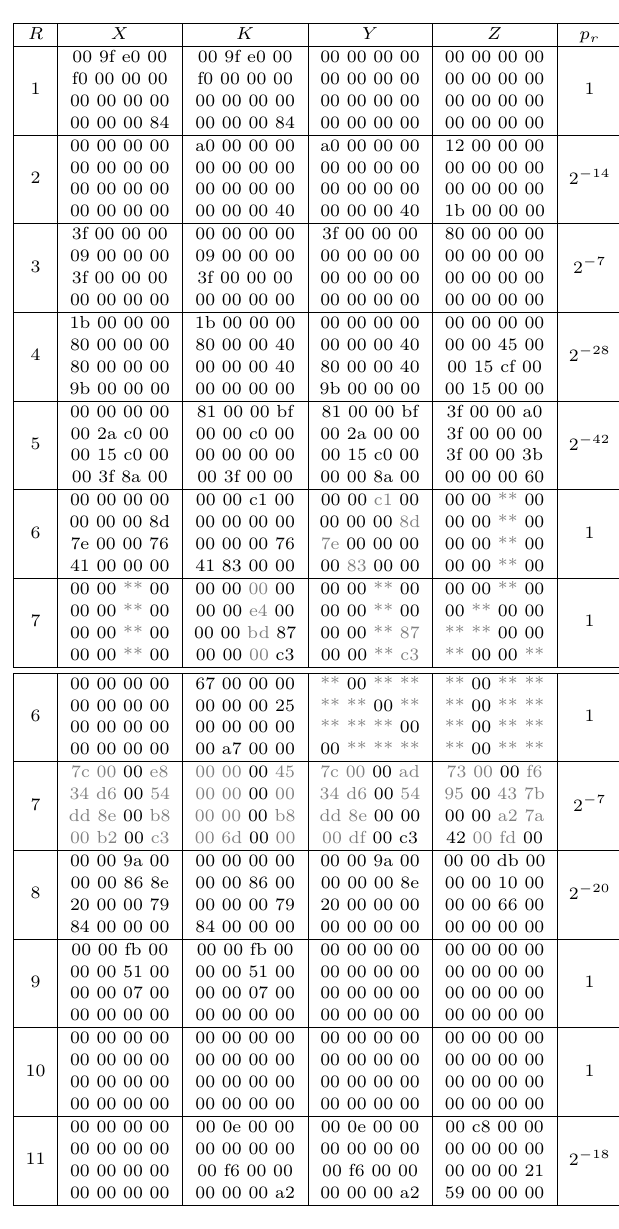
Table 10: 11-round distinguisher of Deoxys-BC-256 . The S-box switch is used in Round 7 (lower) for the S-box at position